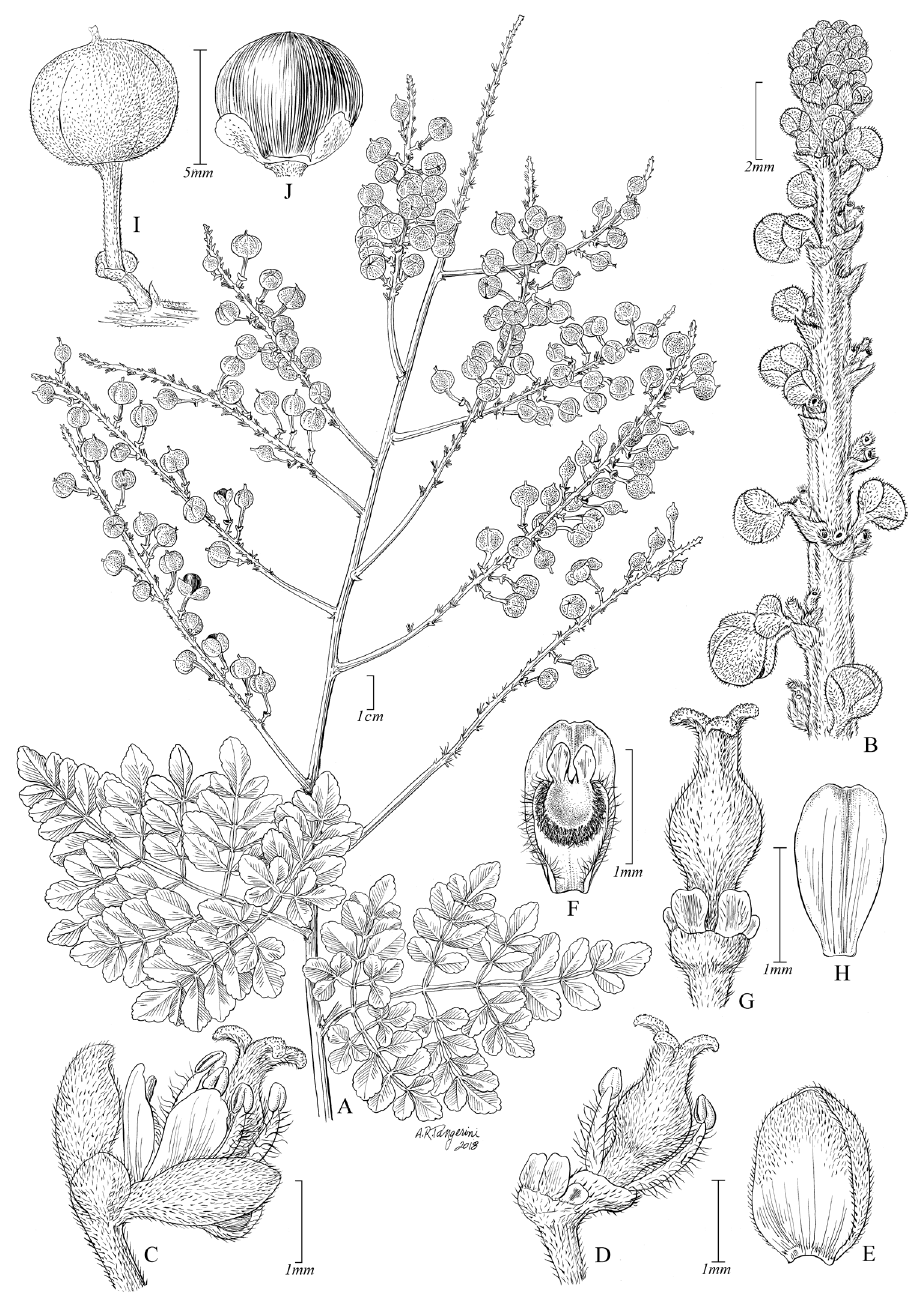
Figure 1. Paullinia cidii . A Fruiting branch B Detail of inflorescence with flower buds C Pistillate flower, lateral view D Pistillate flower with removed perianth, showing nectary glands and torus E Posterior sepal, frontal view F Posterior petal with appendix, frontal view G Gynoecium and nectary glands at base, poste- rior view H Posterior petal dorsal view I Mature capsule J Seed, dorsal view. A, I, J from J.E.L.S. Ribeiro et al 2660 (US) B–H from Zartman 7124